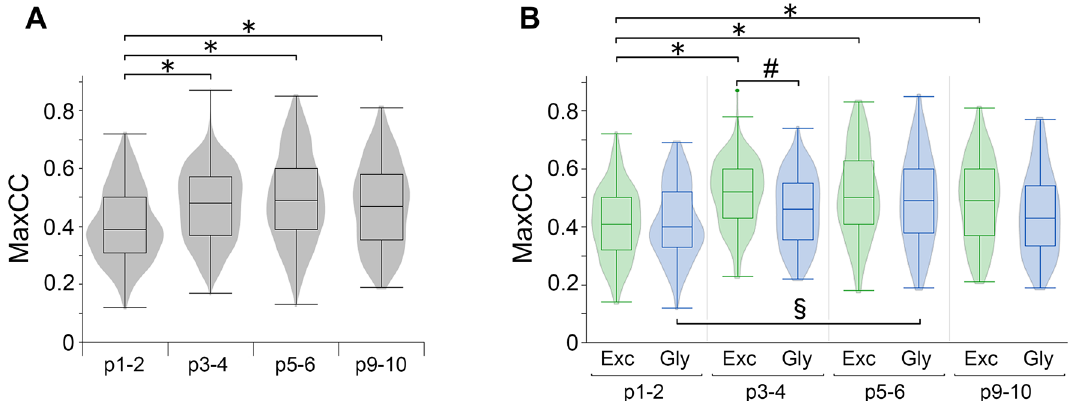
Figure 3. Differences in the relationship of activity patterns of inspiratory neurons to rhythmic bursting patterns of the preBötC during early postnatal development. MaxCC is used as an index to reflect the number and peak timing of action potentials firing on inspiratory neurons. Previously, we showed that inspiratory neurons with larger maxCC exhibited clear waveforms of intracellular calcium rises later in the activation sequence during rhythmic burst. ( A ) Violin plots with box-and-whisker plots show the probability density distribution and the median maxCC of all inspiratory neurons at respective ages. The plots were calculated from 400, 466, 385, and 269 cells detected from n = 5 mice at each time point from p1–2 to p9–10. Significant differences were evaluated among age groups (* p < 0.05 vs. p1–2, Kruskal ‒ Wallis one-way ANOVA). ( B ) Violin plots with box-and-whisker plots show the probability density distribution and the median maxCC of putative excitatory and glycinergic inspiratory neurons at respective ages. The plots were calculated from 107, 175, 236, and 179 putative excitatory inspiratory neurons and 213, 241, 127, and 81 glycinergic inspiratory neurons, which were detected from n = 5 mice at each time point from p1–2 to p9–10. Significant differences were evaluated among all combinations of populations divided by ages and neuron types. Only the differences between neuron types per age group and the differences among age groups per neuron type are shown ( p < 0.05 vs. p1–2 of putative excitatory inspiratory neuron type (*), p1–2 of glycinergic inspiratory neuron type (§) and inspiratory putative excitatory neuron type per age group (#), two-way ANOVA). In both ( A,B ), the line in the box shows the median maxCC; the upper and lower edges of the box show the 75th and 25th percentiles of the maxCC; and both ends of the whisker show the maximum and the minimum maxCC in each